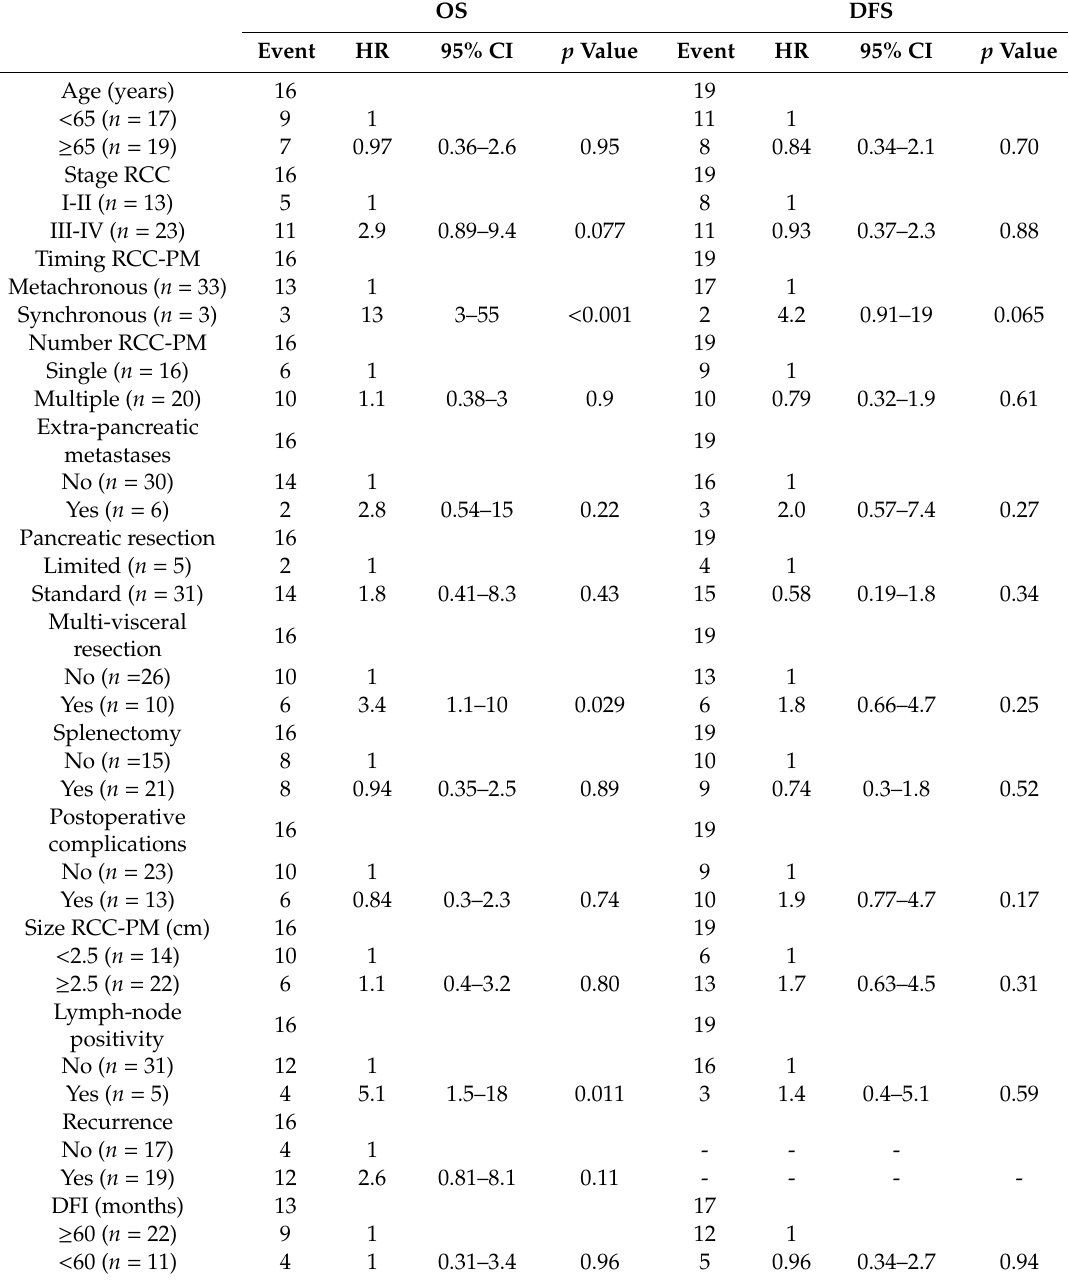
Table 3. Univariate Cox regression analysis for OS and DFS ( n =